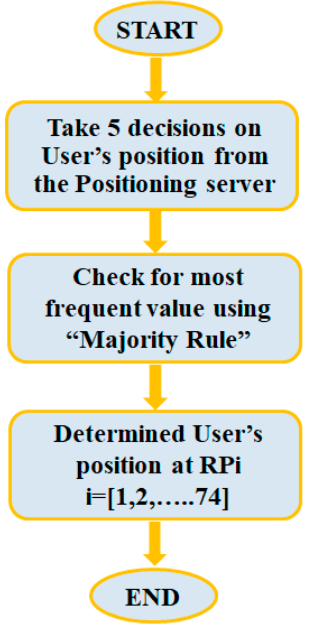
Figure 6. Flow graph for the proposed post-processing algorithm.